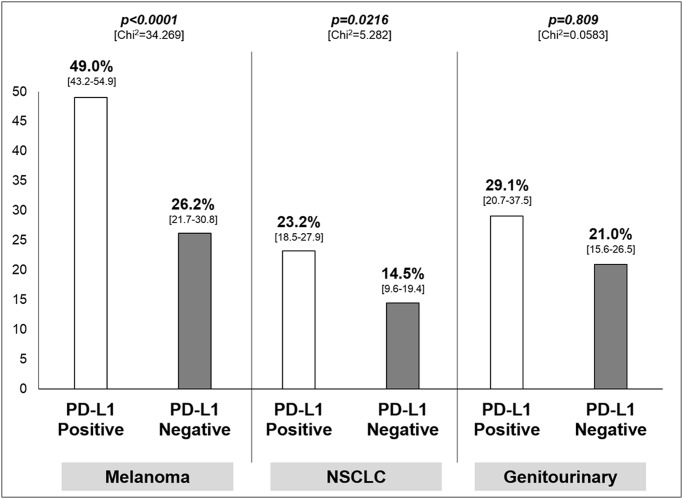
Results of the sensitivity analysis—Overall response rate, with 95% confidence interval in square brackets, according to tumor type.Chi2: Chi-square test; PD-L1: programmed death-ligand-1; NSCLC: non-small cell lung cancer.